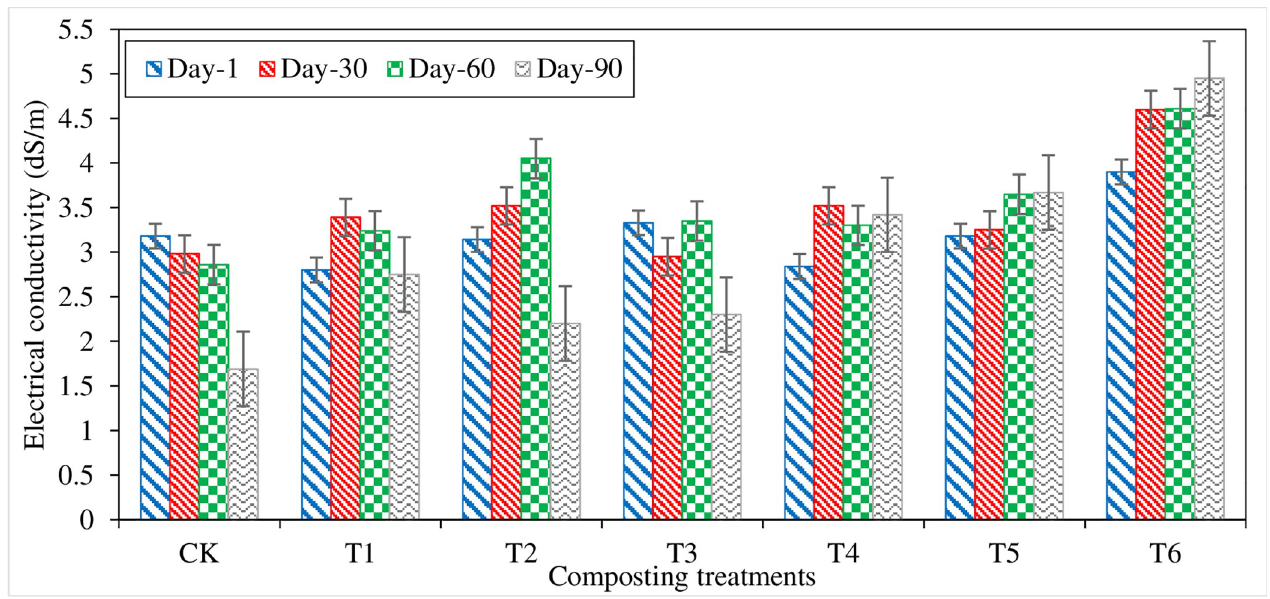
Fig 3. Electrical conductivity (EC) measured from different composting treatments.